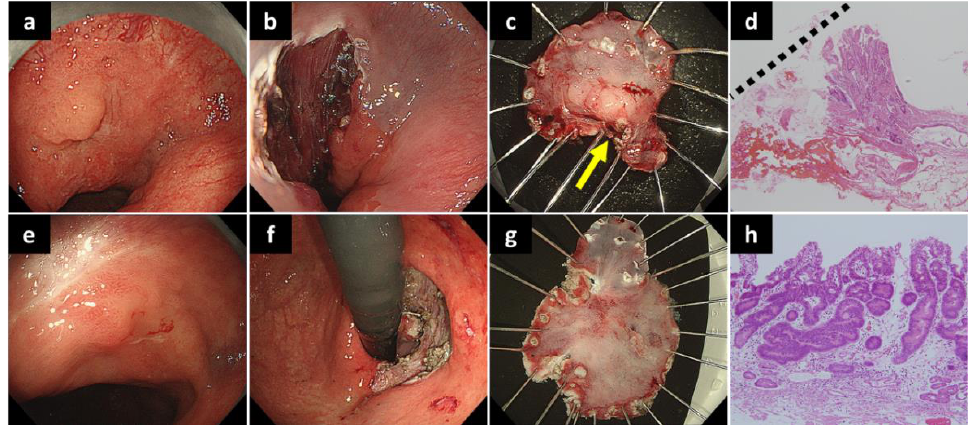
Figure 3. A case of local recurrence after ESD. ( a ) A 20 mm-sized elevated gastric cancer was observed by the cardia in the remnant stomach. ( b ) The lesion has been removed by ESD. ( c ) The margins of the lesion are close to the horizontal section. ( d ) Tumor cells are exposed on the resection surface (dashed line) (HE staining). The horizontal margin is evaluated as positive. ( e ) Eight months after ESD, a gastric carcinoma appears on the anorectal side of the post-ESD scar. It is judged to be a residual recurrence. ( f ) The local recurrence cancer is completely removed by the second ESD. ( g ) The resected specimen immediately after the second ESD. ( h ) The resected specimen shows a well-differentiated tubular adenocarcinoma. Horizontal and vertical margins are negative (HE staining). ESD, endoscopic submucosal dissection; HE, hematoxylin and